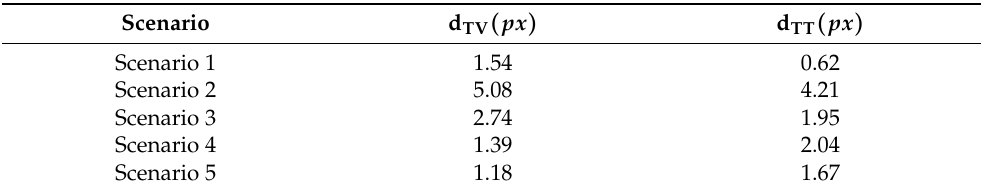
Figure 11. Training dataset cluster radius for various synthetic image ratios for all classes. Table 7. Distance between training and validation clusters and training and testing clusters for varying ratios of synthetic training